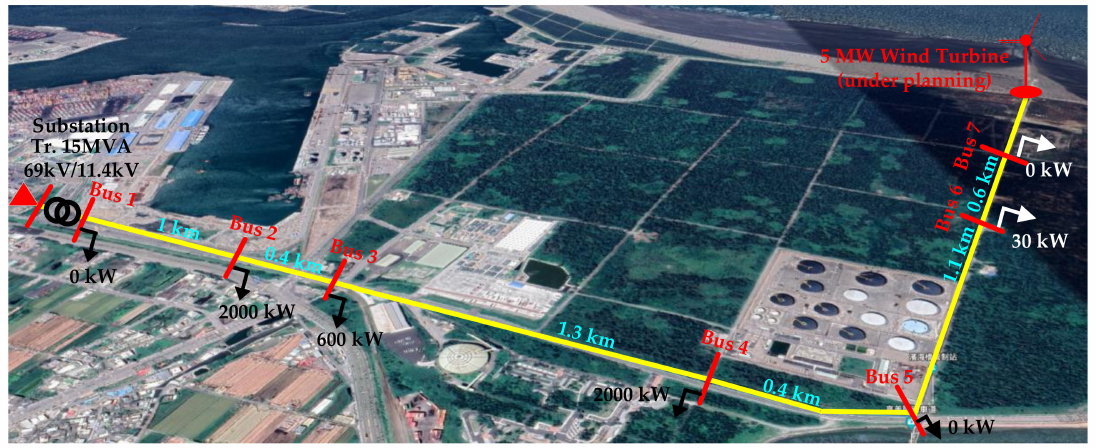
Figure 5. 7 bus testing distribution feeder for PV hosting capacity (PVHC)